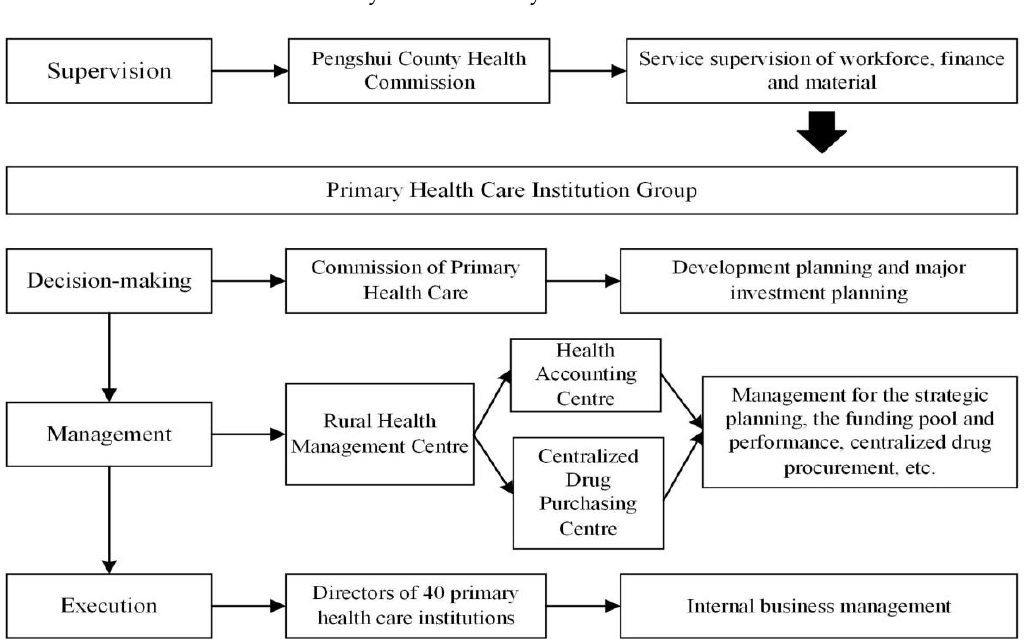
Figure 1. The governance structure of the Pengshui model.